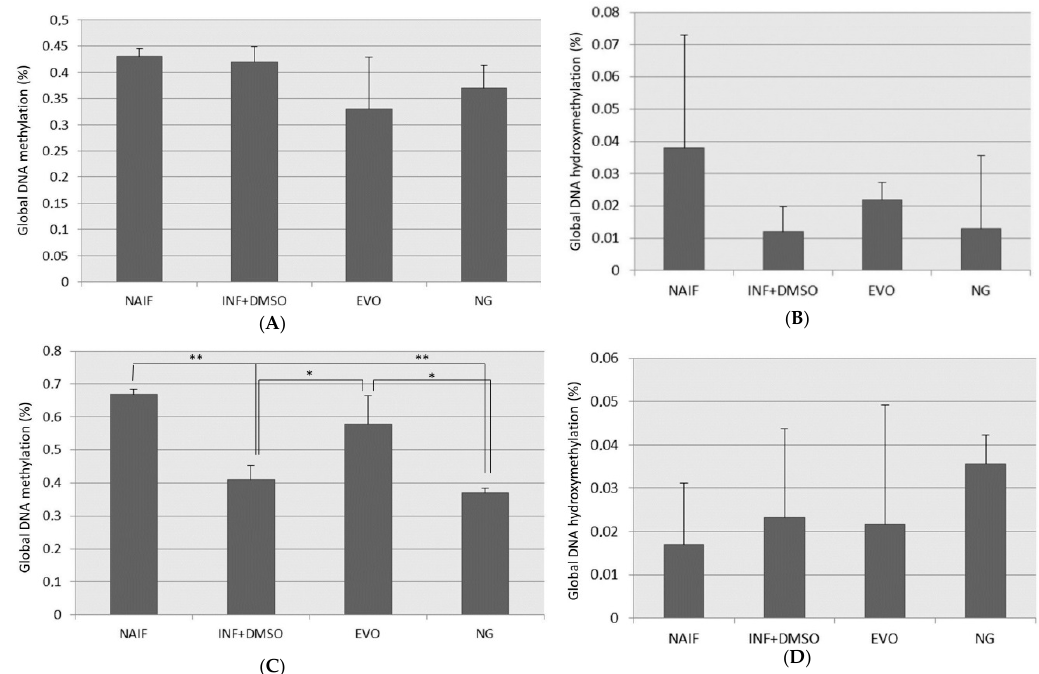
Figure 5. Global DNA methylation and hydroxymethylation levels measured under the different Figure5. GlobalDNAmethylationandhydroxymethylationlevelsmeasuredunderthedifferentconditions conditions for the two experimental settings: ( A ) DNA methylation for SET1; ( B ) DNA for the two experimental settings: ( A ) DNA methylation for SET1; ( B ) DNA hydroxymethylation for SET1; hydroxymethylation for SET1; ( C ) DNA methylation for SET2; ( D ) DNA hydroxymethylation for ( C ) DNA methylation for SET2; ( D ) DNA hydroxymethylation for SET2; *: p < 0.05; **: p < 0.01. SET2; *: p < 0.05; **: p < 0.01.